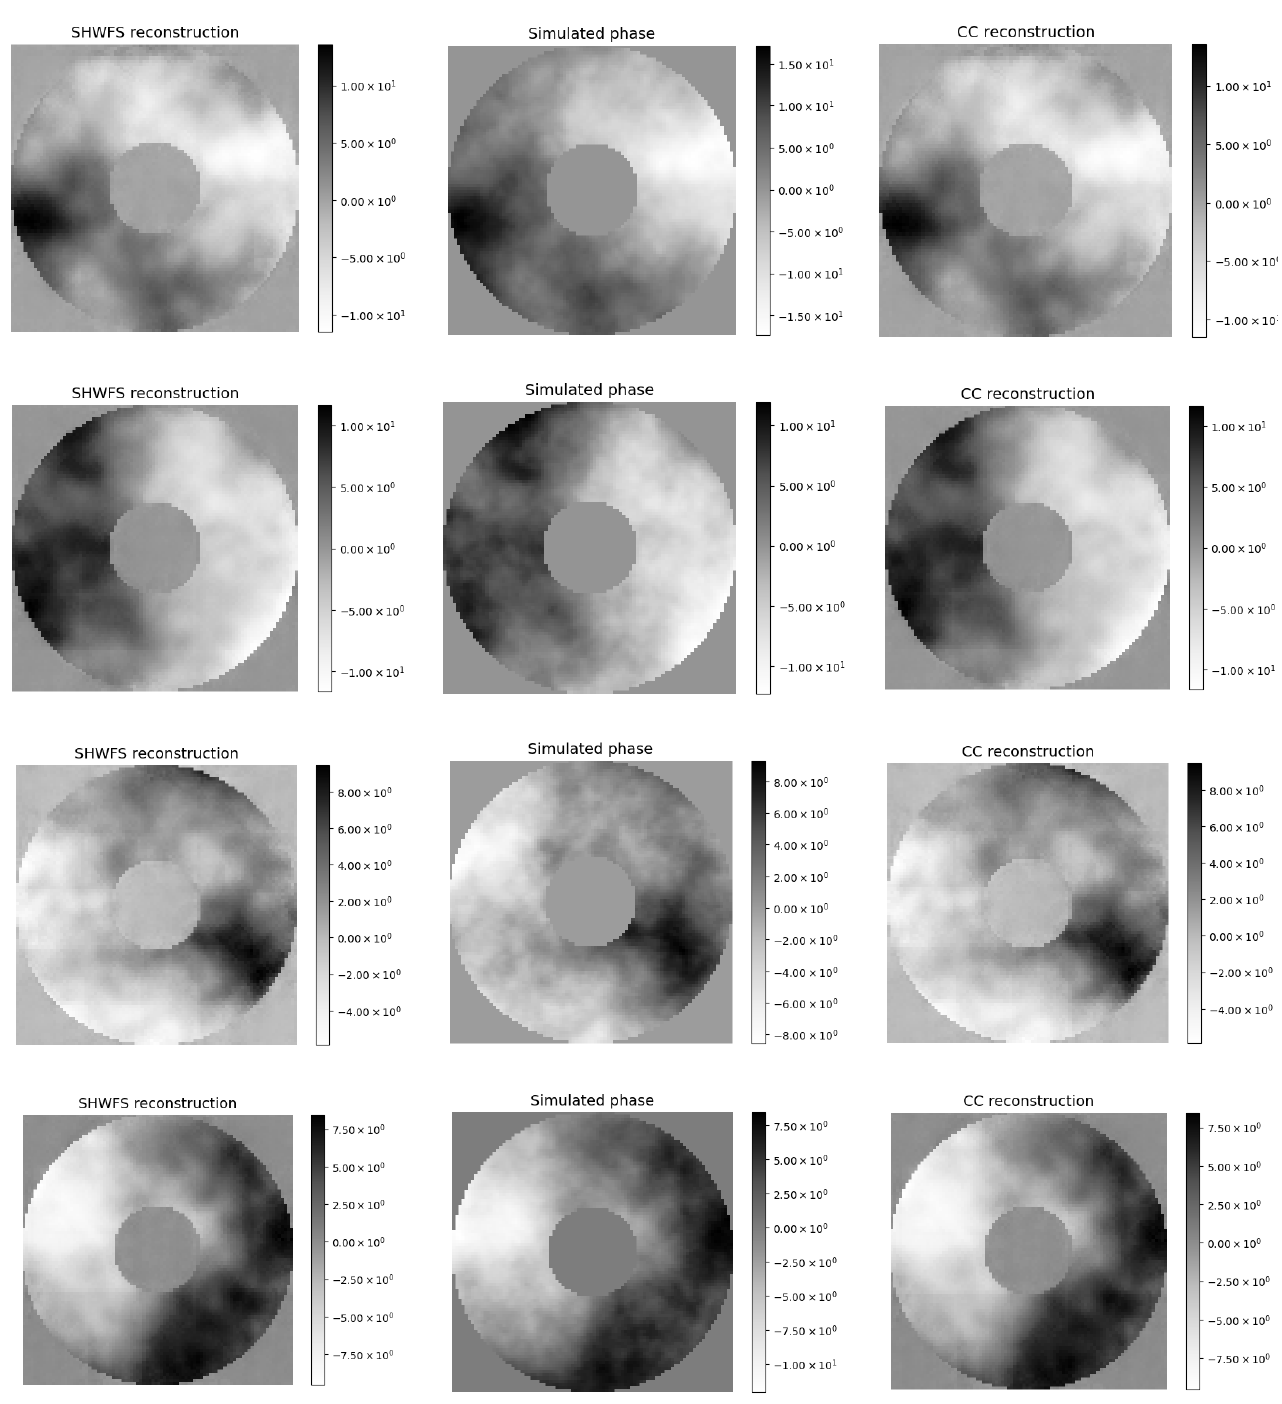
Figure 4. Comparison of the reconstructed phases for ground layer turbulences with the original one. Each row corresponds to an example of a sample of each test dataset used with r 0 values from 7 to 17 cm in steps of 2 cm and its corresponding reconstructions. On the left, the reconstructions carried out by the FCN whose inputs are directly the information received by the SHWFS are shown. In the center of the image, the original turbulence phase simulated is shown, while on the right, the reconstructions carried out from the cross-correlations are shown.